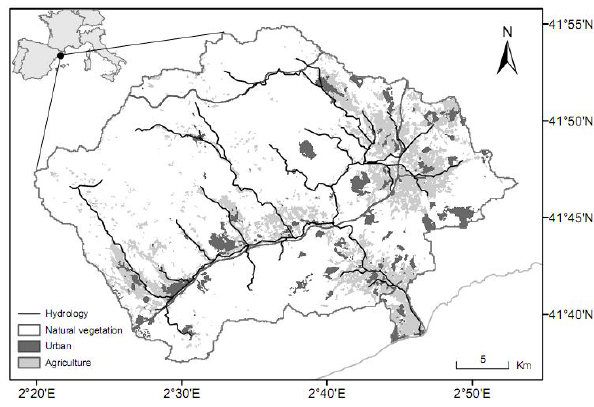
Fig. 1. Location of La Tordera catchment in Catalonia (southern Europe), showing main land uses for the year 1997 and the river network. Source: original, based on data from Catalan Cartographic Institute (ICC, Institut Cartogr`afic de